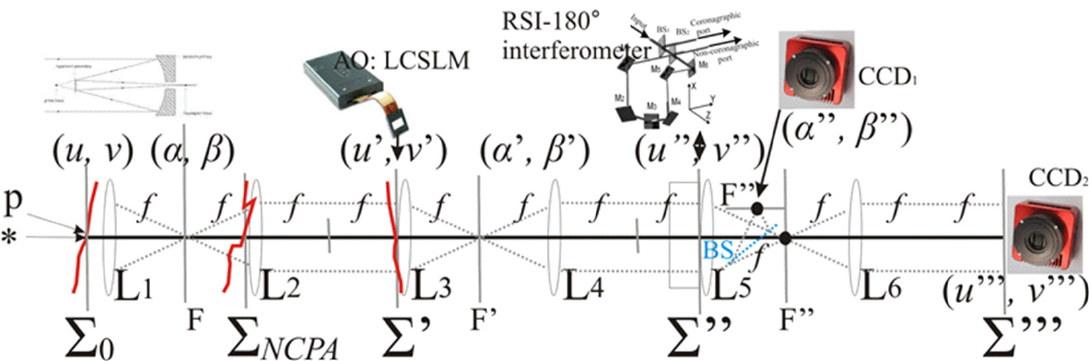
Figure 5. Optical scheme to assemble telescope by AO, interfero ‐ coronagraph, field camera, and pupil camera for PSI technique.